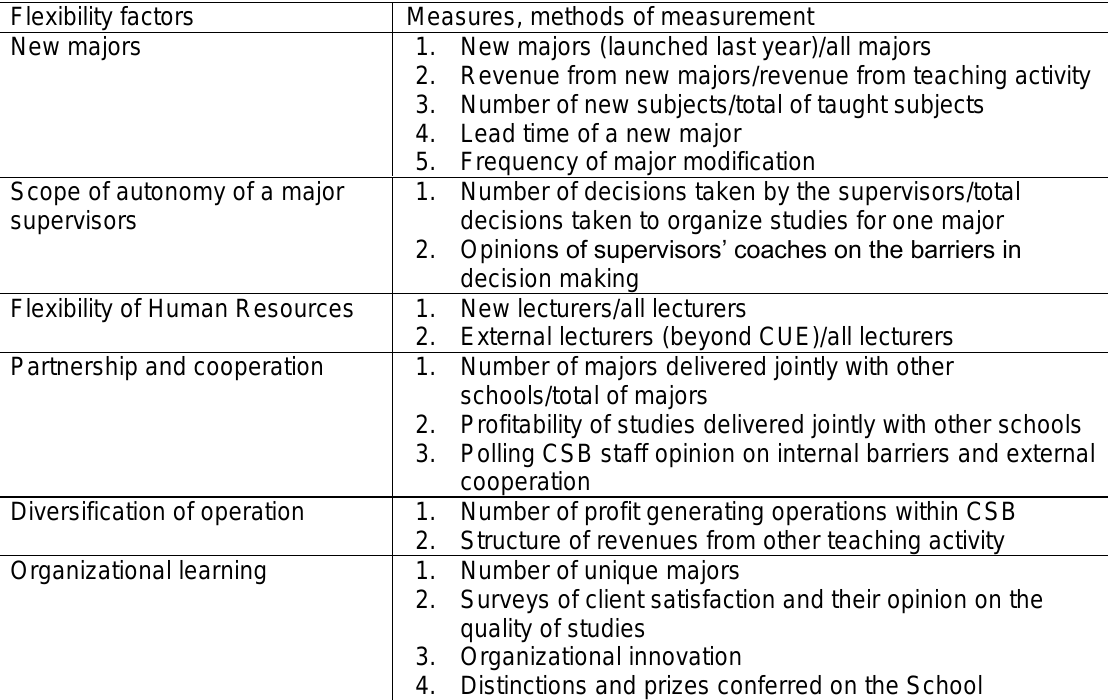
Table 2: Flexibility factors and the methods of measurement in Cracow School of